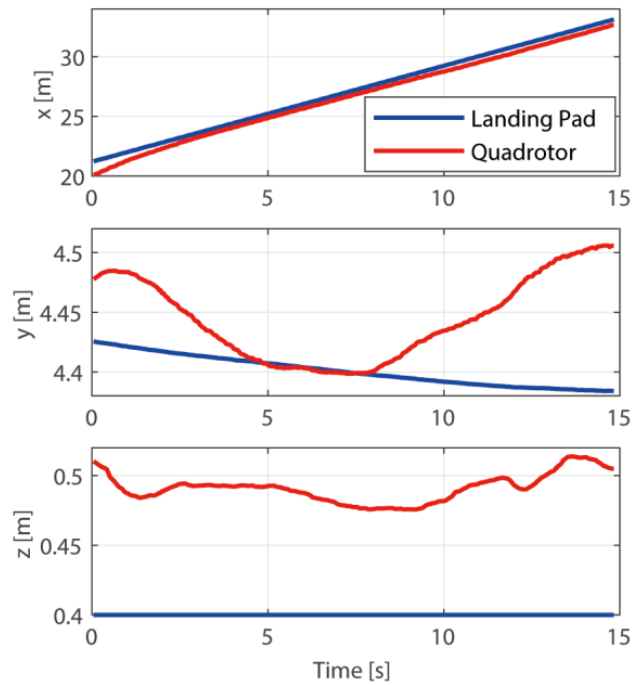
Figure 4. Trajectory of quadrotor and landing pad. Then, we planned the landing trajectory using the method proposed in this paper. As shown in Figure 5, the drone initially hovers at 2 m in the z -direction, and the UGV is between buildings. A collision-free trajectory needs to be planned to ensure the drone’s safety.